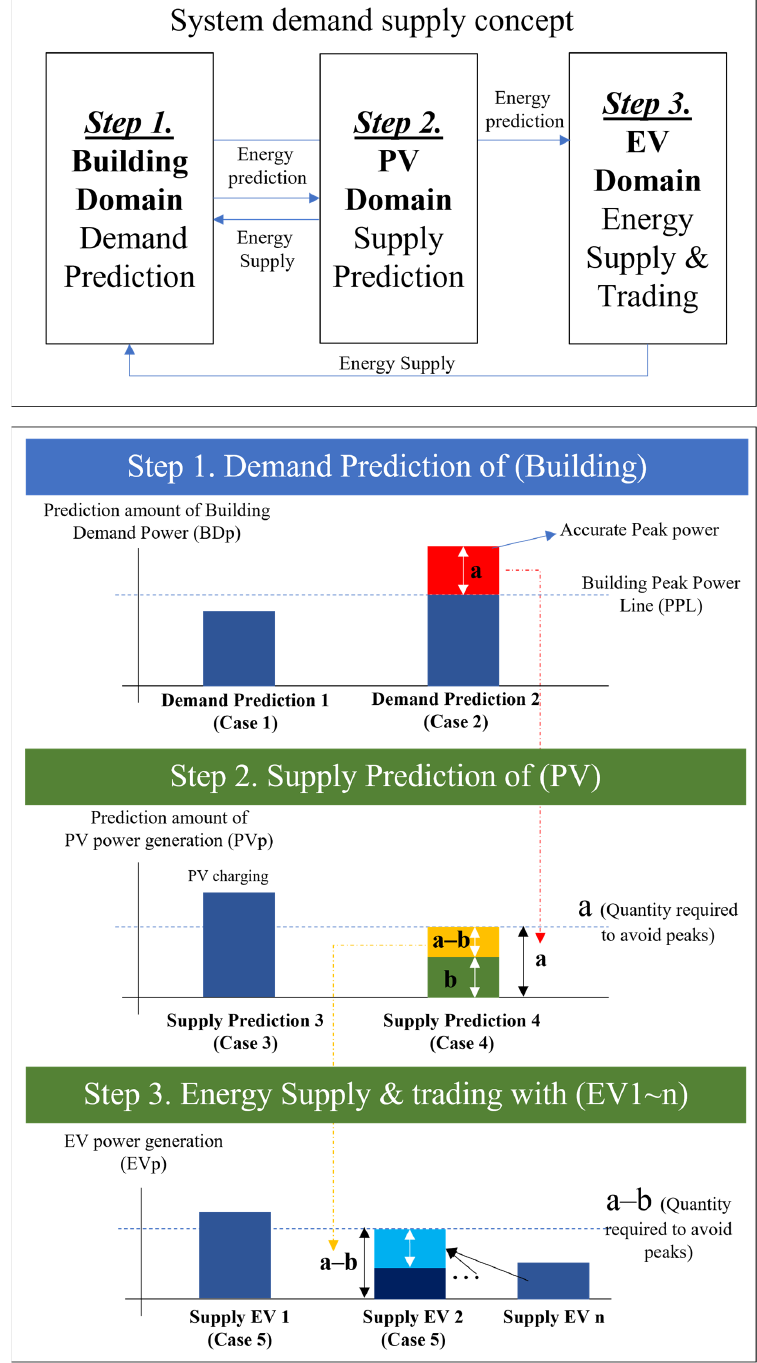
Figure 10. Energy supply strategy of the building’s energy